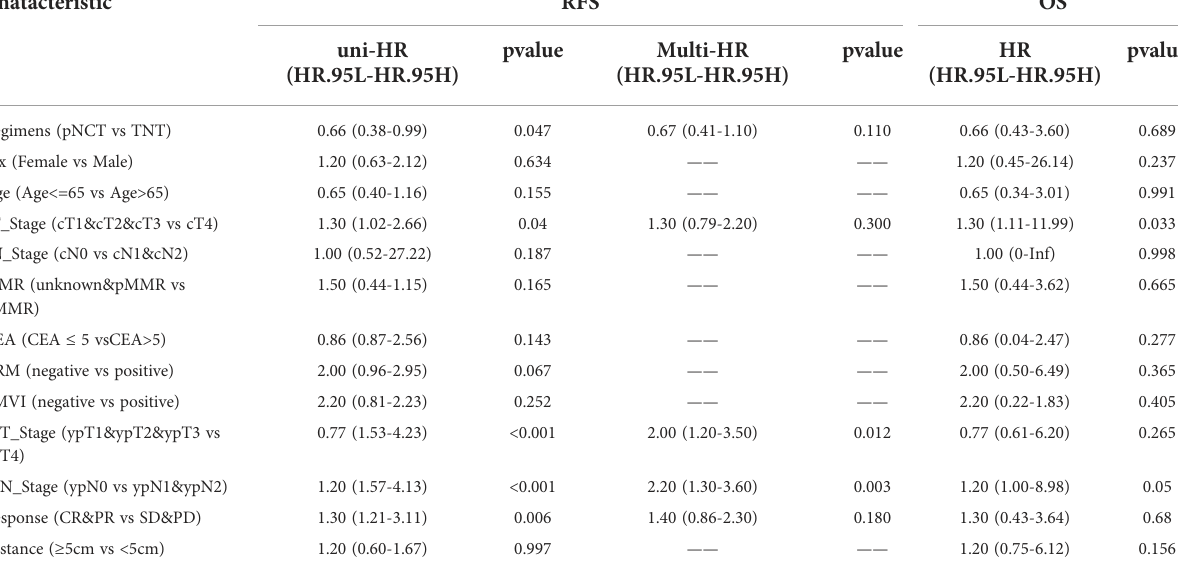
TABLE 5 Univariable and multivariable analysis of the effects of prognostic factors on recurrence-free survival and overall survival.